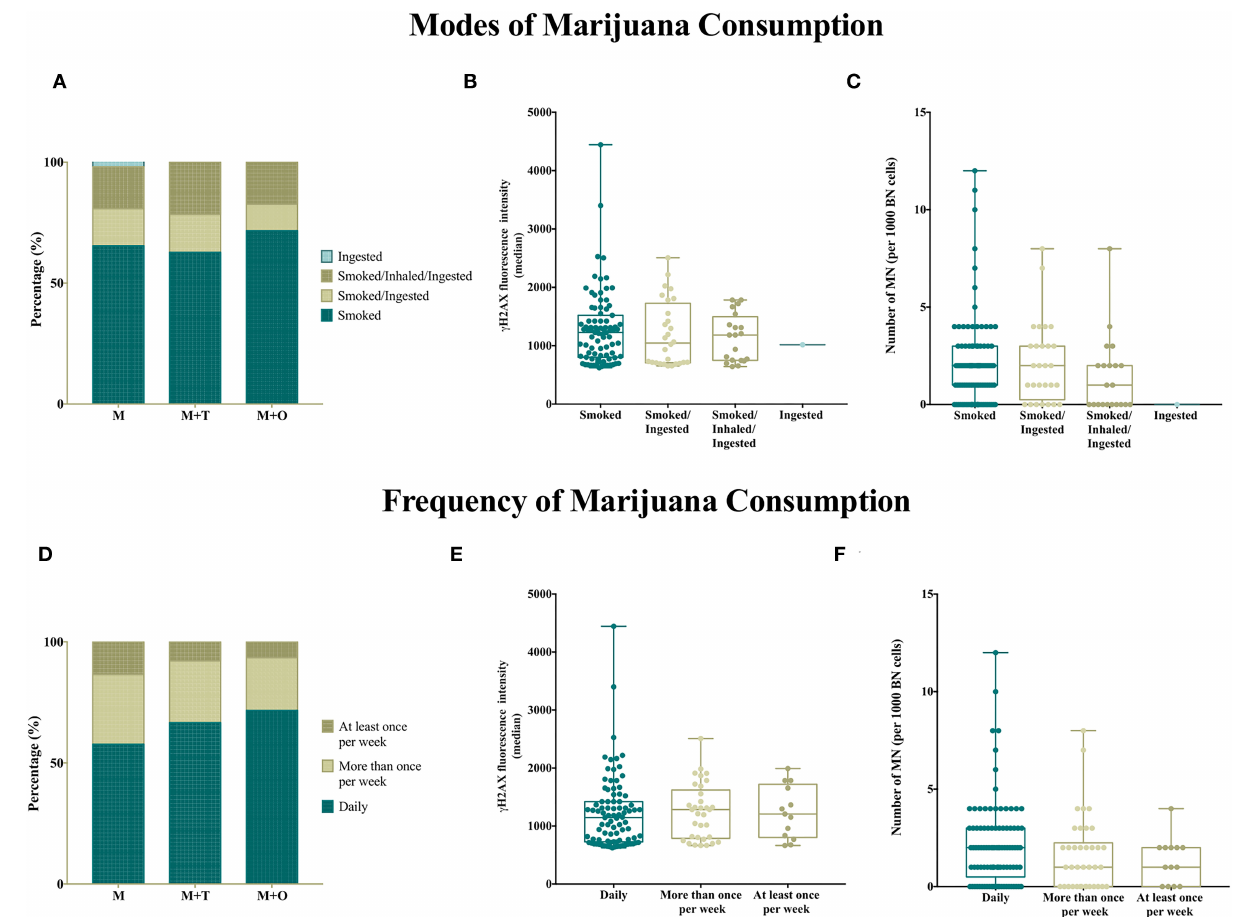
FIGURE 2 | Smoking and daily consumption of marijuana associate with increased genotoxicity. (A) Proportion of users reporting different modes of marijuana consumption. “ Smoked ” is the most popular mode of consumption across groups. (B) The median fluorescence intensity (FI) of γ H2AX is increased in peripheral blood lymphocytes from users that reported “ smoked ” as their mode of marijuana consumption. (C) The number of MNs is increased in users who reported “smoked” as the only mode of marijuana use. (D) Proportion of users reporting their frequency of marijuana consumption. “ Daily ” consumption is the most common among users. (E) The median fluorescence intensity (FI) of γ H2AX is increased in peripheral blood lymphocytes from users that reported “ daily ” as their frequency of use. (F) The frequency of MN tends to increase when the frequency of marijuana use